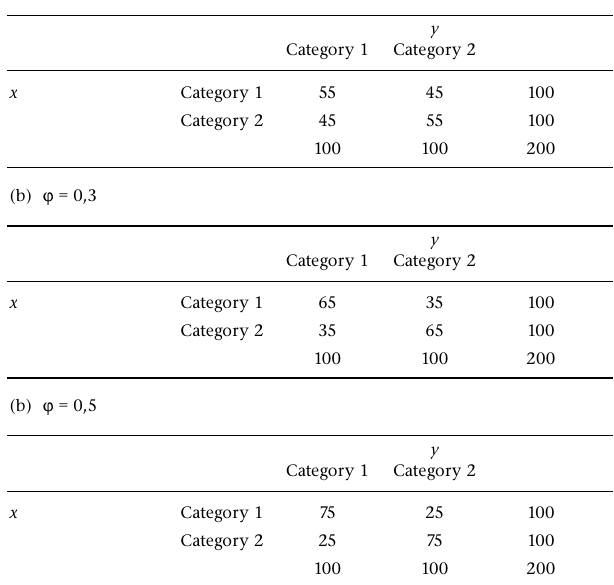
From Table 4 the effect sizes in respect of the relationship between the personality type scores and the